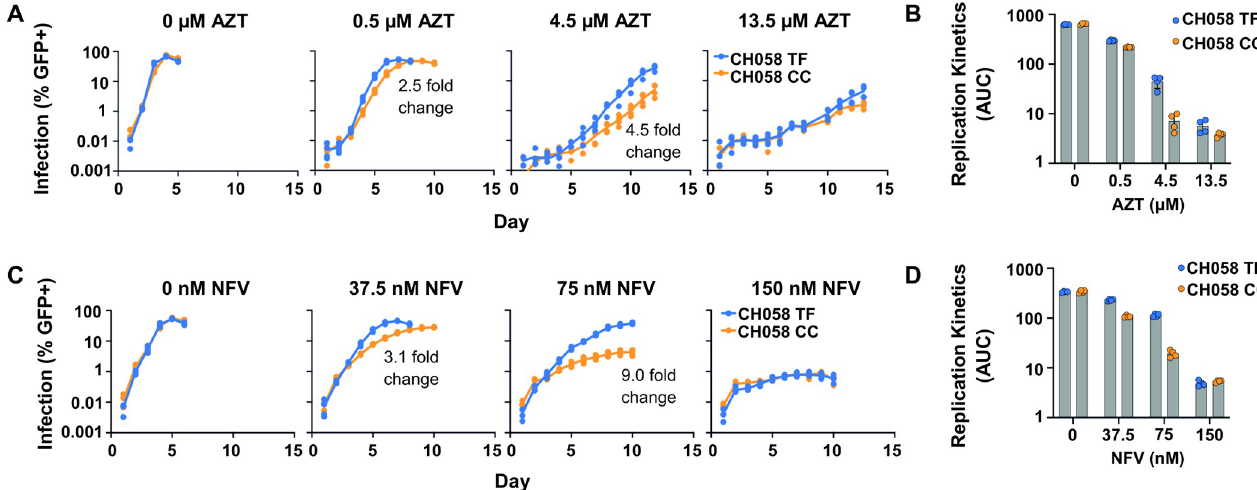
Fig 6. Transmitted HIV-1 is more resistant to antiretroviral drugs compared to the matched chronic virus. (A-B) TMZR5 cells were pre-treated with a range of azidothymidine (AZT) doses for 2 hours prior to infection with the CH058 TF or CC virus, cells were sampled daily to monitor virus spread. GFP- positive cells were quantified via flow cytometry. (C-D) TMZR5 cells were pre-treated with a range of nelfinavir (NFV) doses and infected, sampled and quantified as in A. Viral spreading replication experiments took place on two occasions, a typical result is